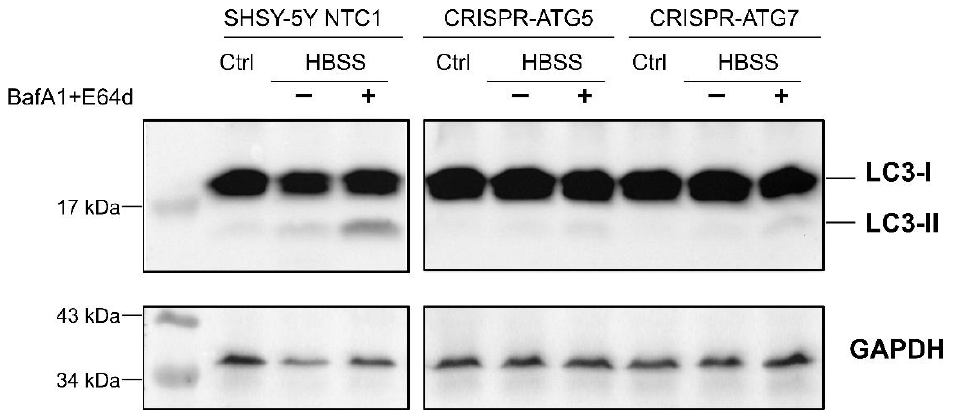
Figure 2. Autophagic flux in parental SH-SY5Y cells compared to their derived autophagy-deficient clones. Cells were either left untreated (Ctrl) or transferred to HBSS for 3 h to induce autophagy; to measure autophagic flux, autophagy inhibitors bafilomycin A1 and E64d were added to HBSS or not 1 h before harvesting the cells; total proteins were extracted, and LC3 conversion to its lipid- conjugated form LC3-II was monitored by Western blot. GAPDH was used as a loading control. 2.3. RF-Induced AR Is Negated in ATG7 and ATG5 CRISPR Cell Lines